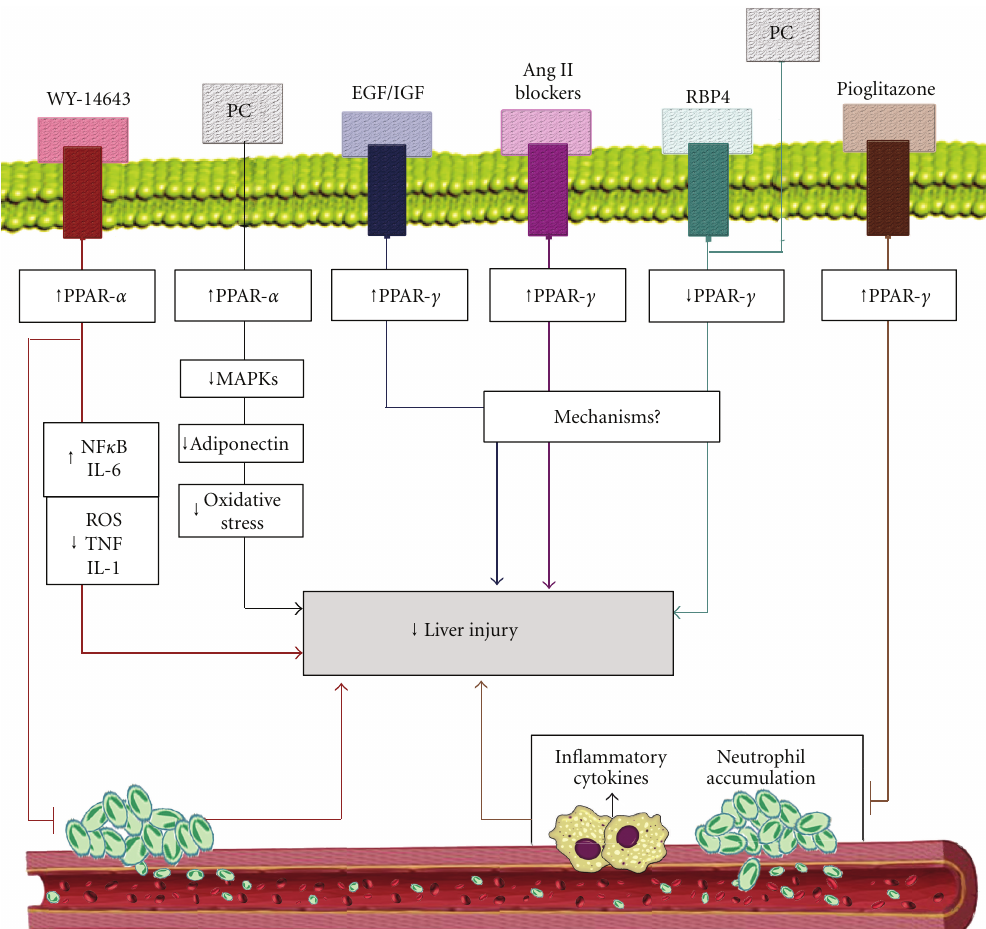
Figure 2: PPAR and hepatic I/R injury. Angiotensin II, Ang II; epidermal growth factor, EGF; insulin-like growth factor, IGF; interleukin- 6, IL-6; mitogen-activated protein kinases, MAPKs; nuclear factor kappa B, NF κ B; PPAR α agonist; pioglitazone, peroxisome proliferator- activated receptors, PPAR; ischemic preconditioning, PC; retinol binding protein, RBP4, PPAR α agonist;